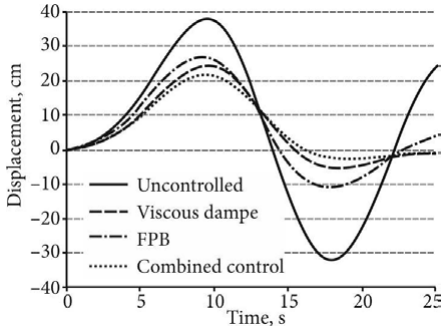
Fig. 6. Vibration reduction effect by different control